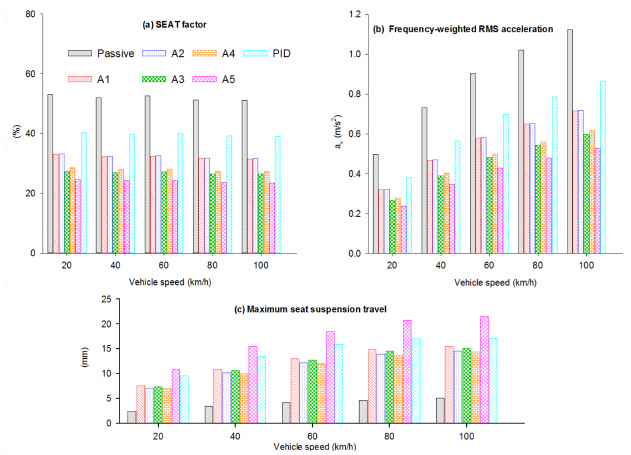
Figure 7. Simulated performance assessment of the proposed active seat suspension under different vehicle speeds. ( a ) SEAT factor; ( b ) Frequency-weighted RMS acceleration; ( c ) Maximum seat suspension factor.